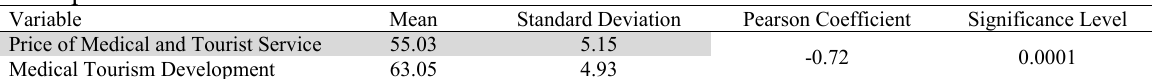
Significant relationship test between price of medical and tourist services and medical tourism development